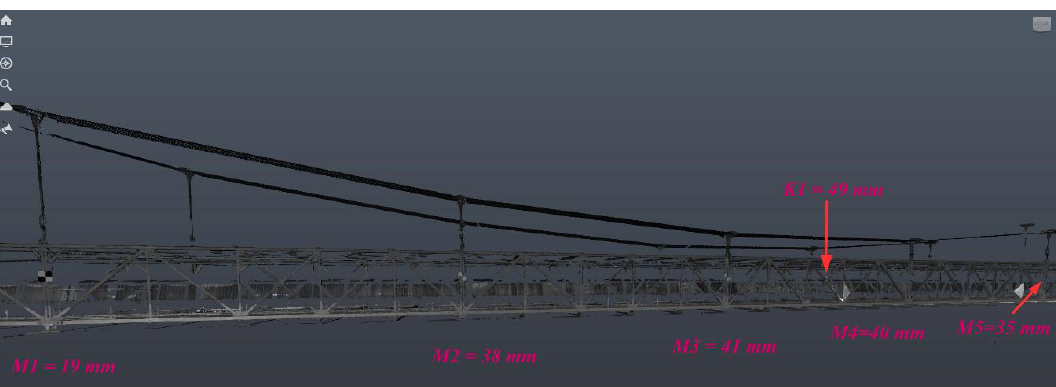
Table 2. Results of the maximum recorded bridge deflections (in mm).